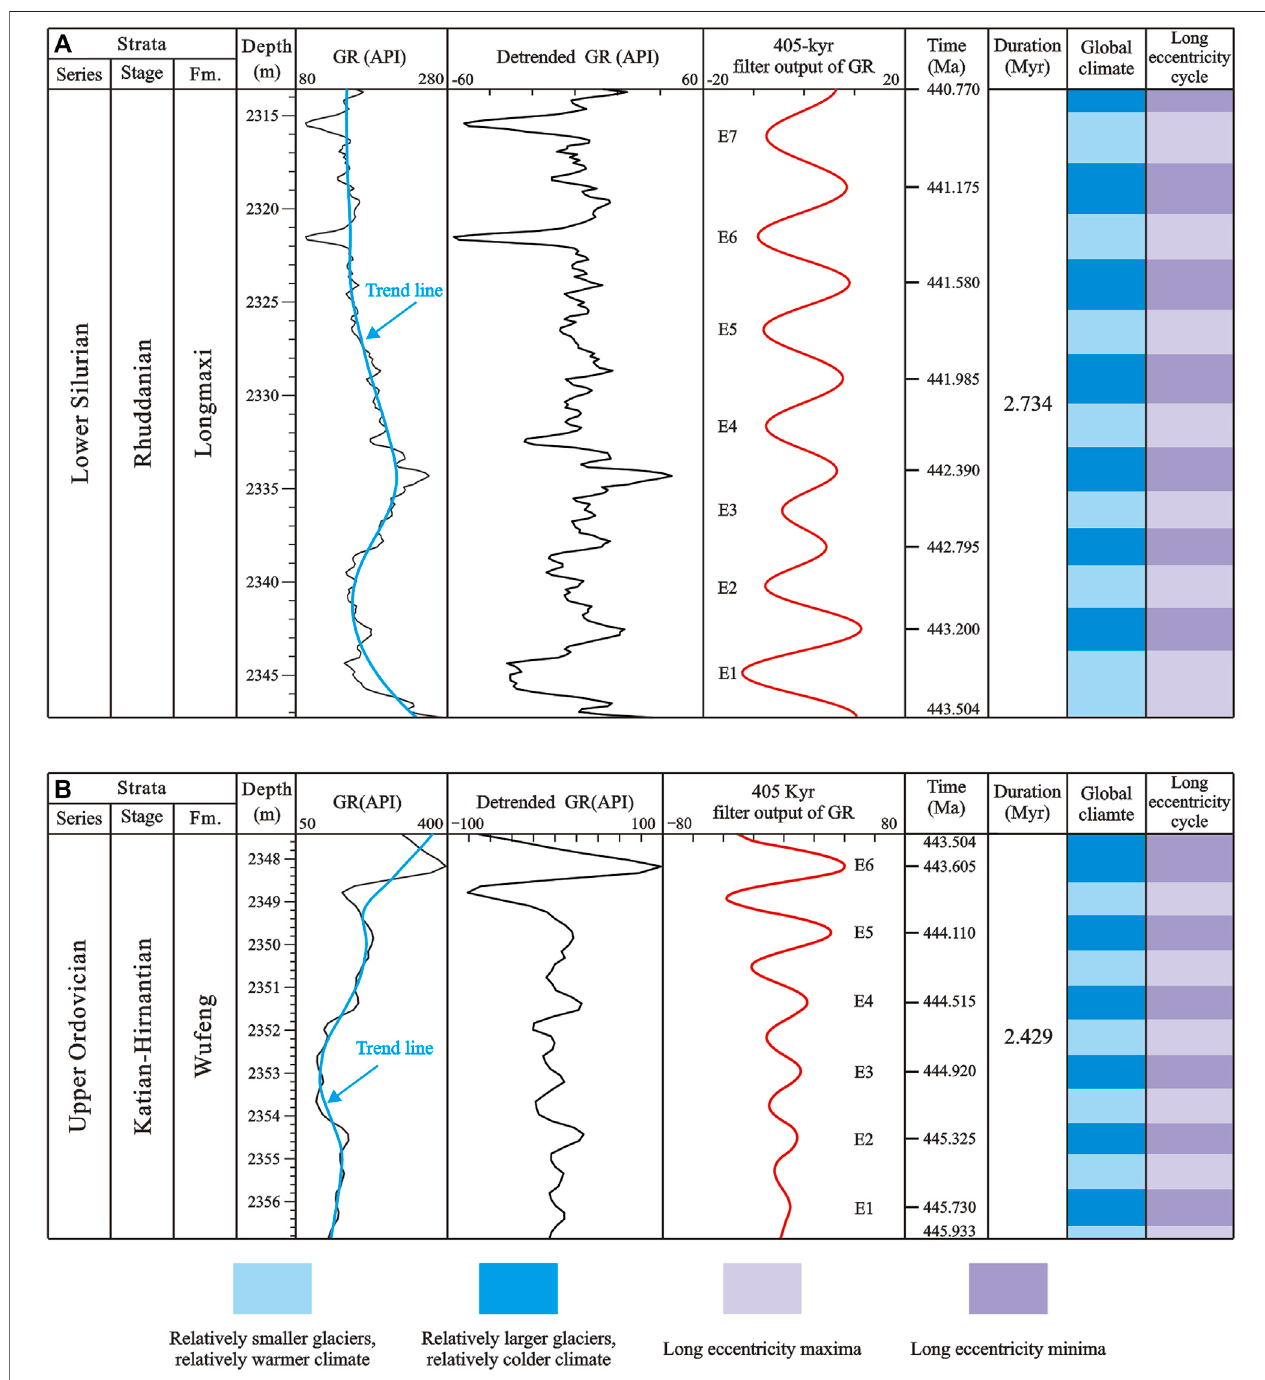
FIGURE 6 | Detrended GR data series and long eccentricity curves obtained through fi ltering of the detrended GR for the (A) lower Longmaxi Formation and (B) Wufeng Formation in well N211 in the Upper Yangtze Region. GR data series were detrended by subtracting 25% weighted averages. (E: 405-kyr long eccentricity).